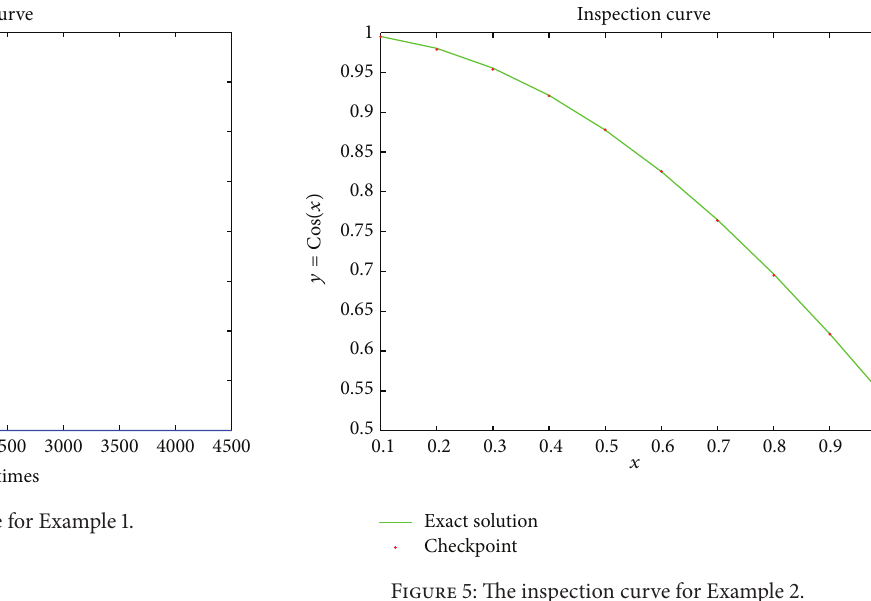
Figure 5: The inspection curve for Example 2.